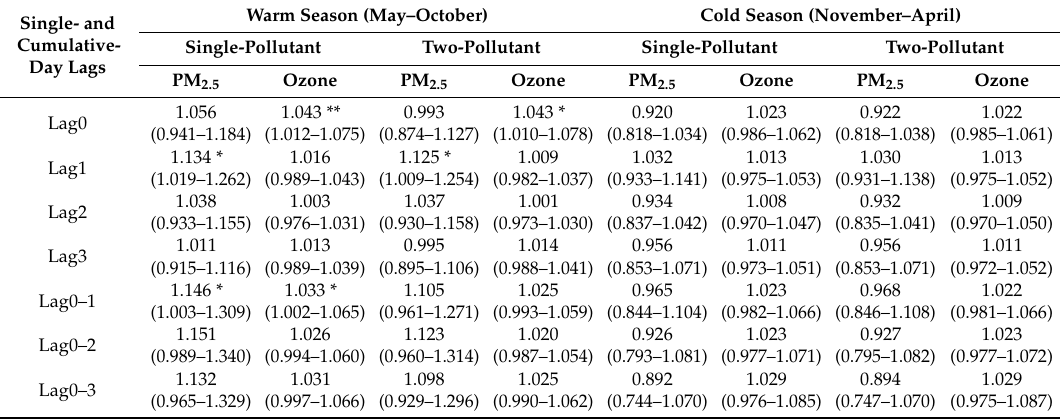
Table 6. Results of the conditional logistic regression analysis stratified by